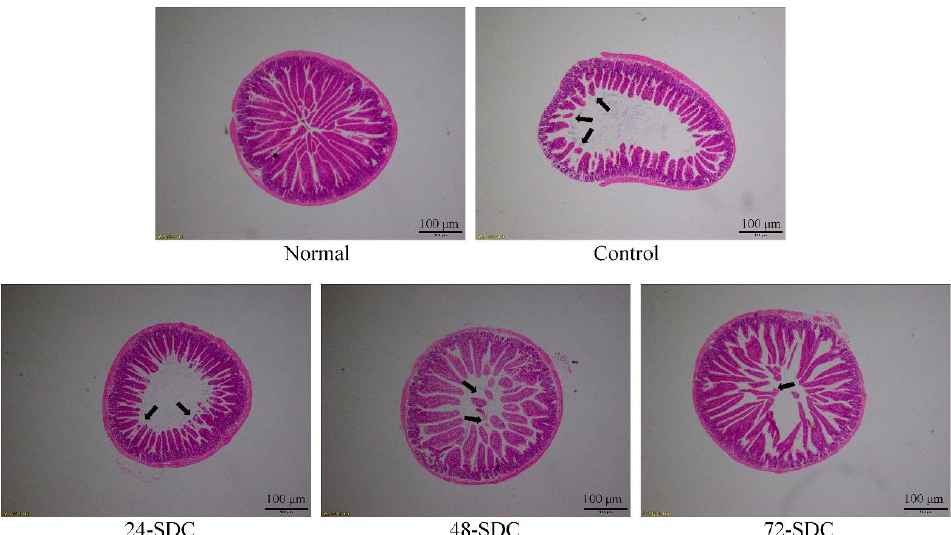
Figure 5. Morphological observation (40×) of small-intestine tissue in mice with diphenoxylate-induced constipation. 24-SDC: 24-h-fermented Shuidouchi; 48-SDC: 48-h-fermented Shuidouchi; 72-SDC: 72-h-fermented Shuidouchi.